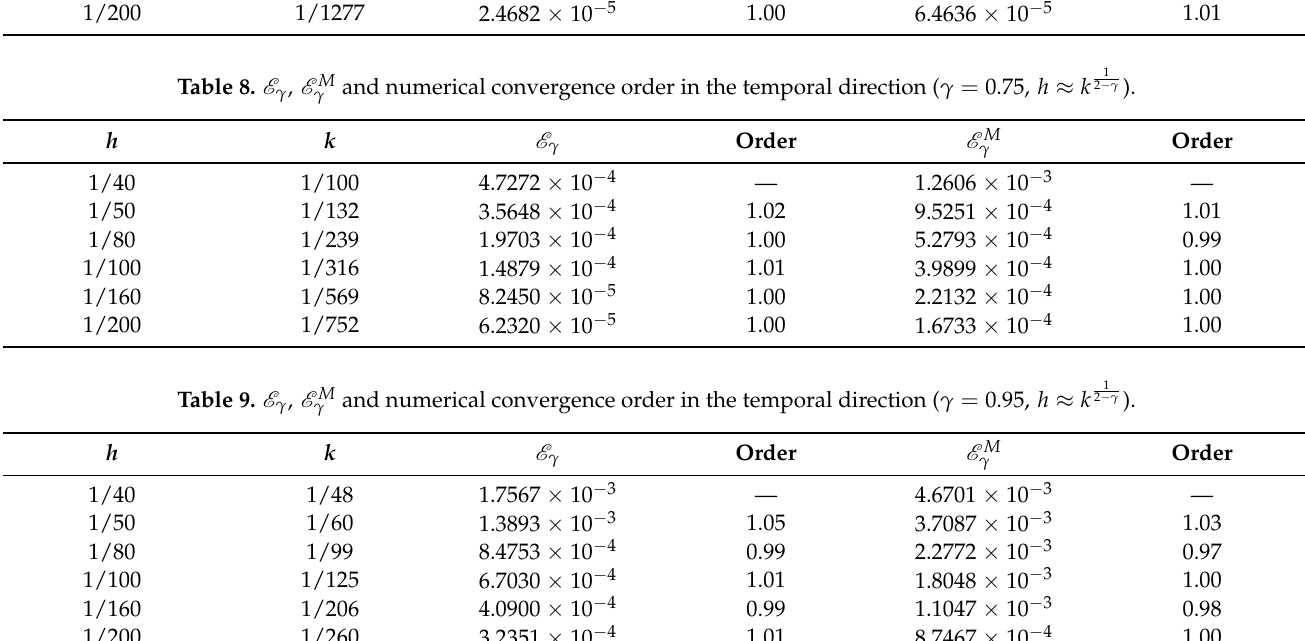
Table 8. E γ , E M γ and numerical convergence order in the temporal direction ( γ = 0.75, h ≈ k